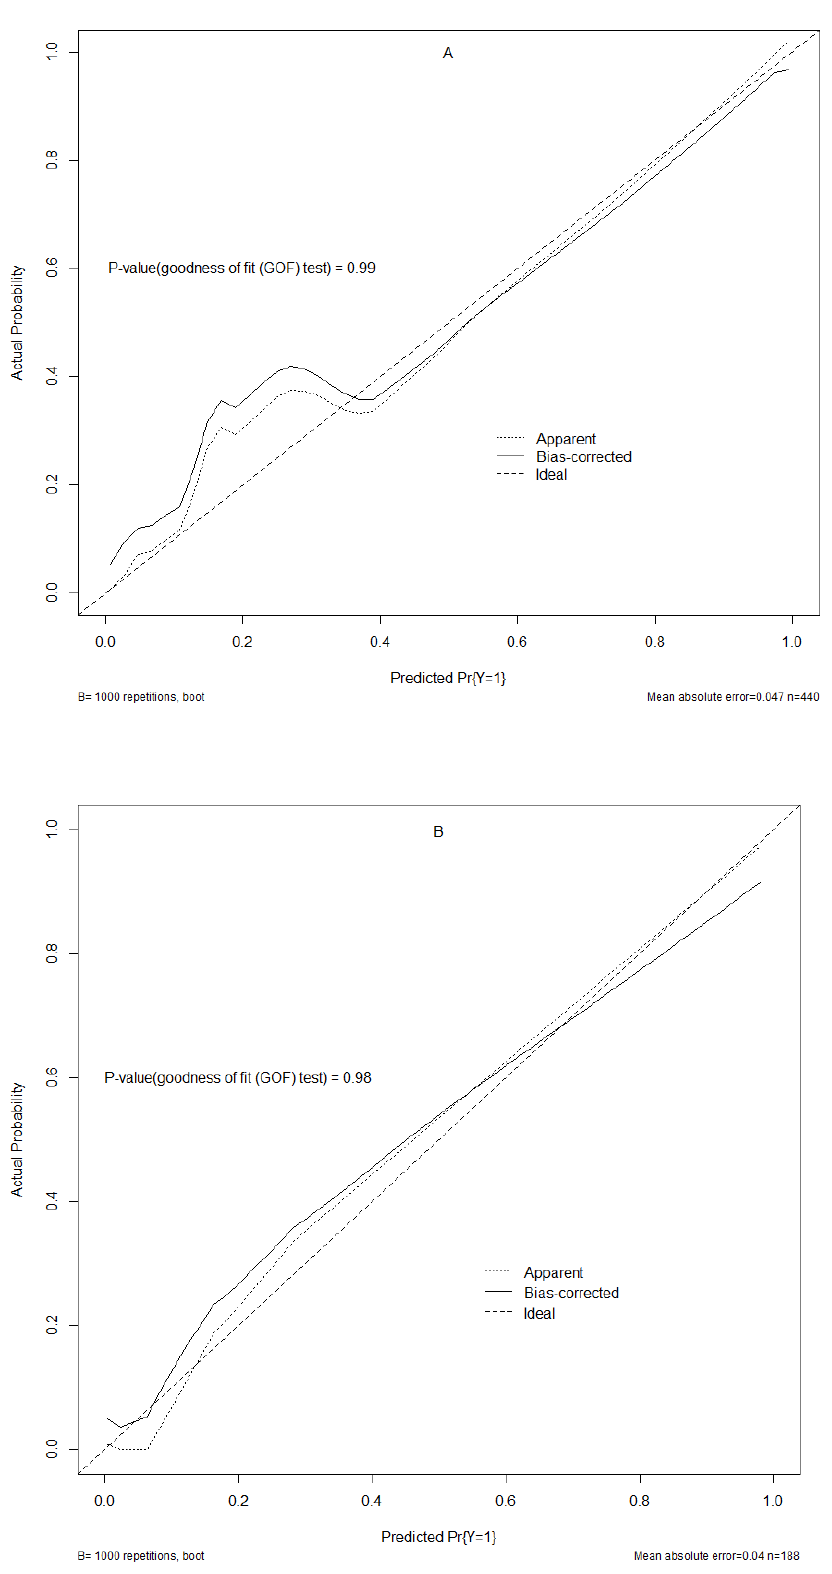
Figure 6. Plot for the calibration curves. ( A ): training set; ( B ): validation set. The ideal (fully fitted), bias-corrected (adjusted), and apparent (actual) curves were calculated by 1000 repetitions of bootstrapping samples. The p values for the training and validation sets’ GOF test were 0.99 and 0.98,